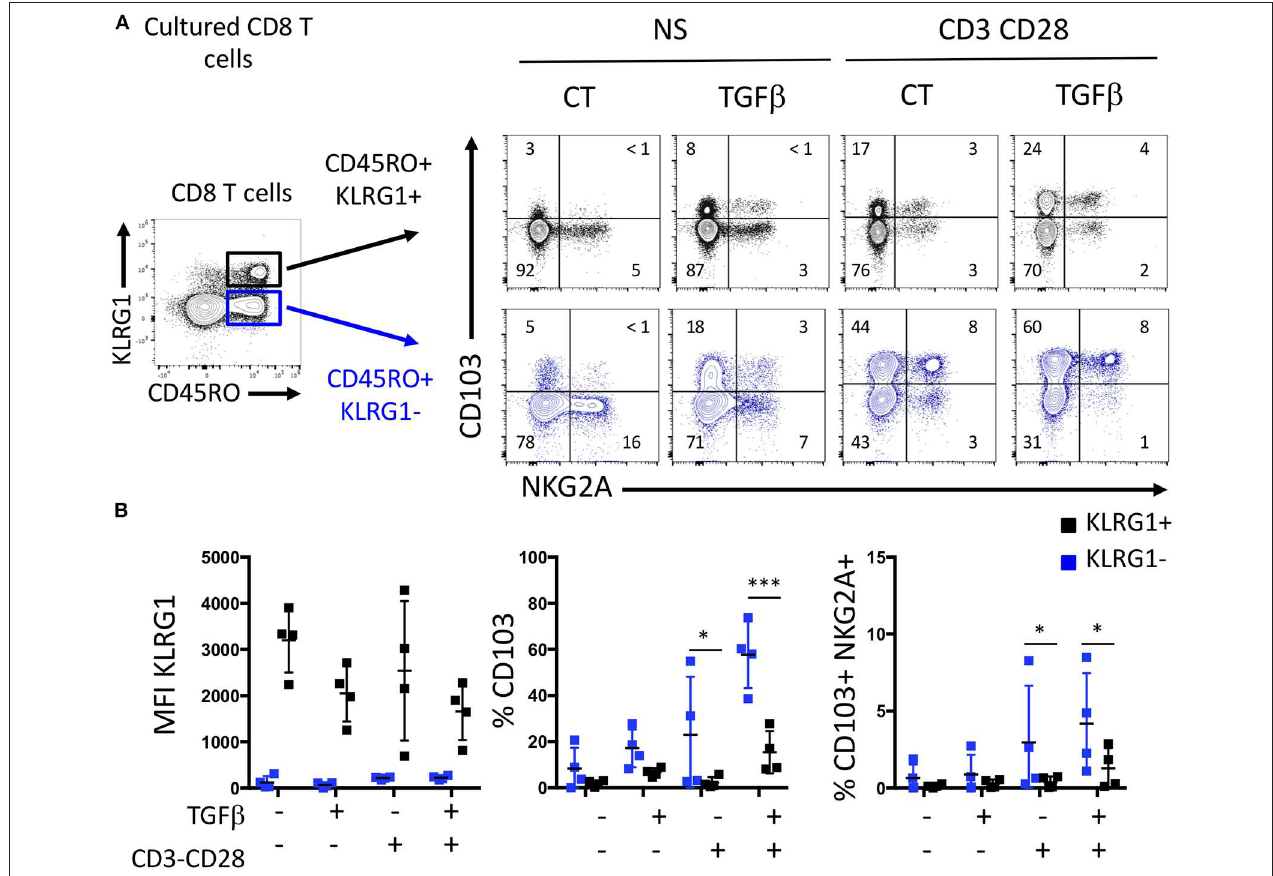
FIGURE 3 | KLRG1-CD8 T cells acquire CD103 following TGF β exposure and TCR triggering. (A) Representative expression of C0103 and NKG2A on sorted memory KLRG1- and KLRG1 + after incubation with or without TGF β and TCR triggering. (B) Quantification of C0103, KLRG1, and C0103 + NKG2A + expression on C08T cells (dots and bars represent 4 independent experiments with mean and SEM; ANOVA with Bonferoni post-test: * p < 0.05, *** p <